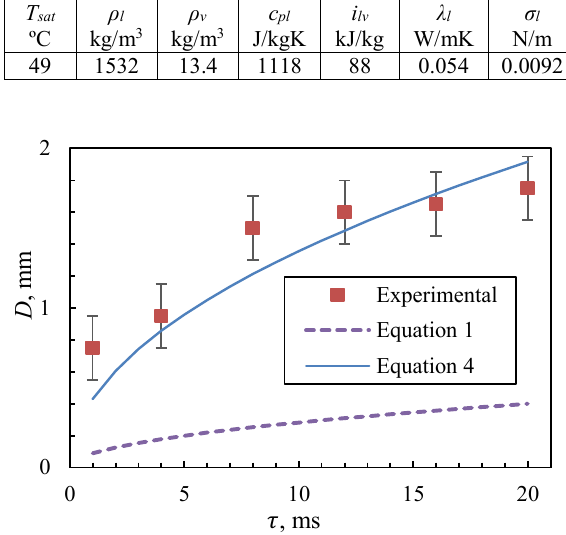
Fig. 4 . Diameter of the growing bubble versus